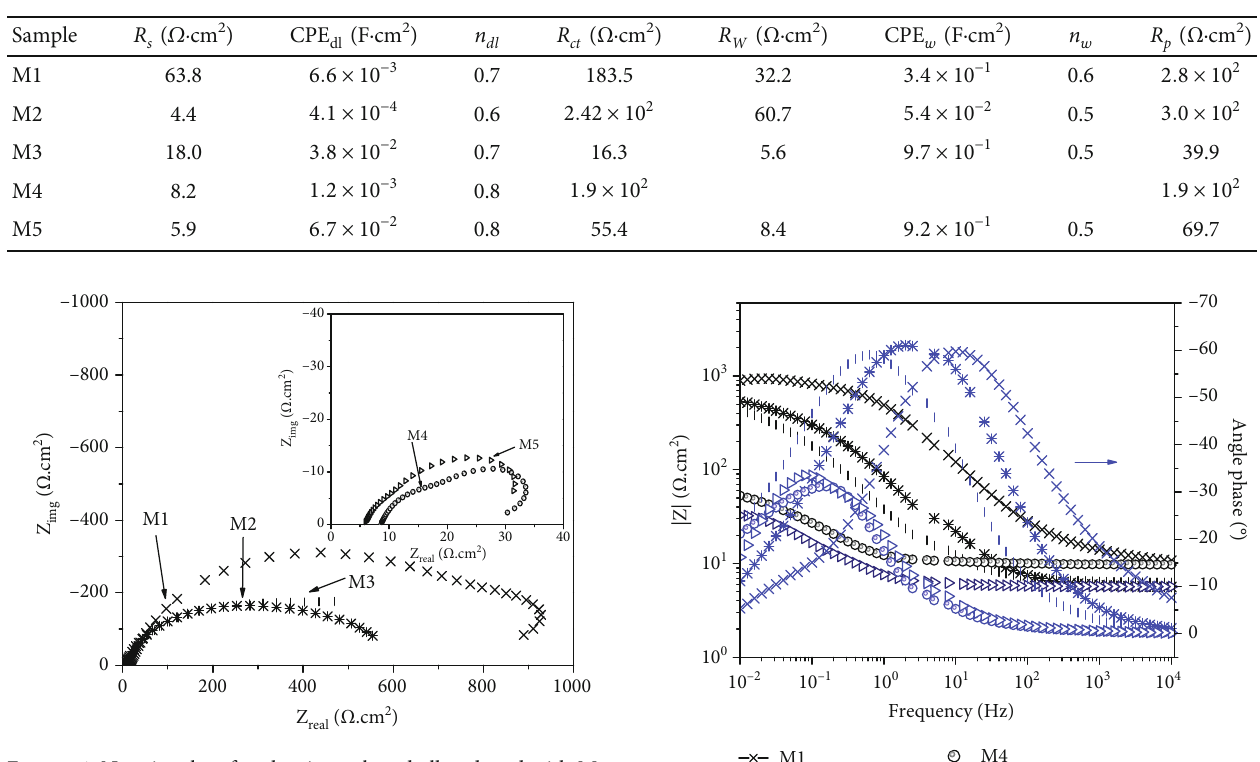
Figure 4: Nyquist plots for aluminum-based alloy doped with Mn and Co after heat treatment at 600 ° C immersed in 3M KOH.